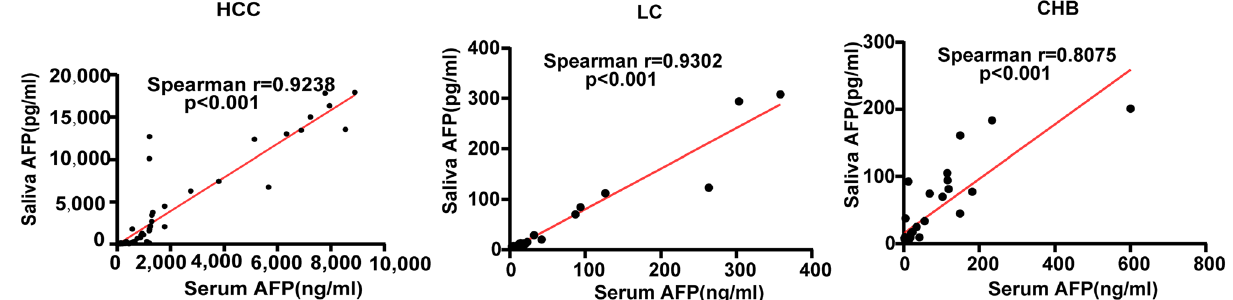
Figure 5. Correlation analysis of salivary AFP and serum AFP. AFP α-fetoprotein, HCC hepatocellular carcinoma, LC liver cirrhosis, CHB chronic viral hepatitis B.